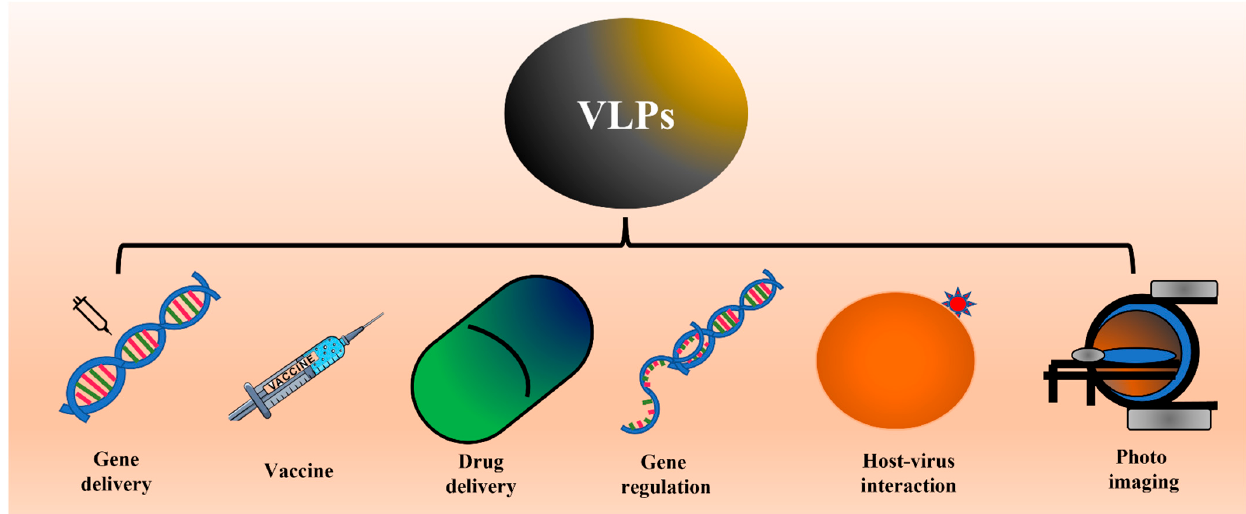
Figure 2. Schematic showing the different applications of VLPs. Several studies have already shown proof of concept for applications like vaccines, drug delivery, and photo imaging. We propose the possible use of VLPs to study virus-host interaction or